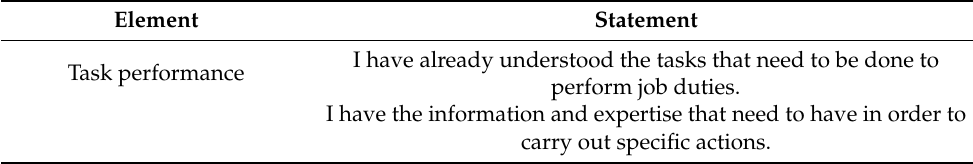
Table 3. Elements and statements of the dimension called task